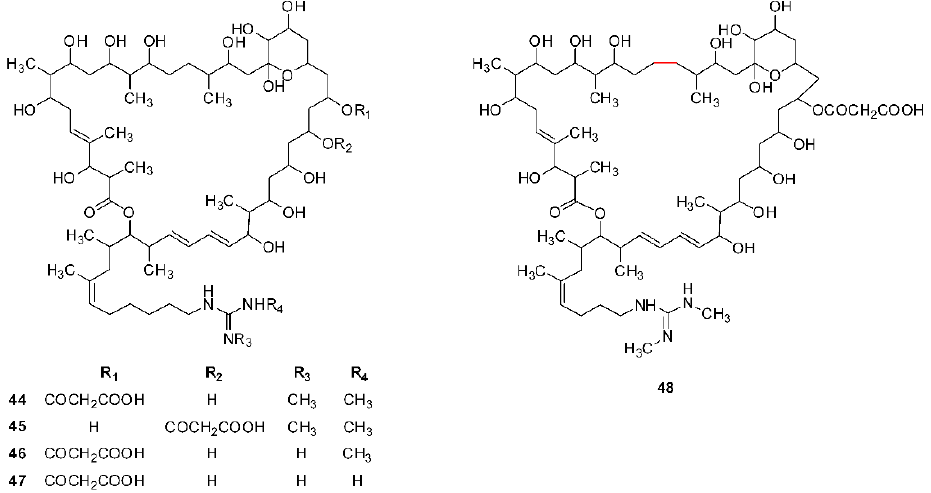
Figure 3. Chemical structures of 40-membered guanidine-containing polyhydroxyl macrolides ( 44 – 48 ).